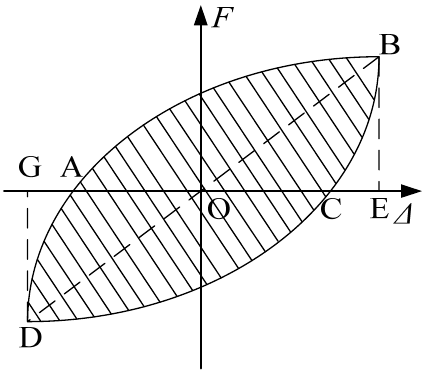
Figure 14. Method used to calculate the equivalent viscous damping ratio.